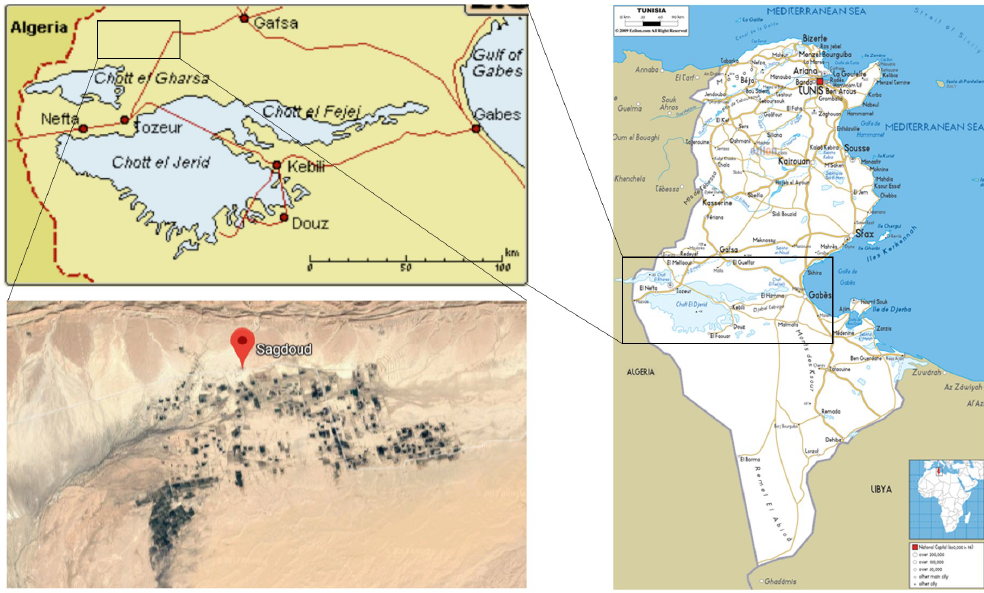
Figure 3. Location map of the oasis of